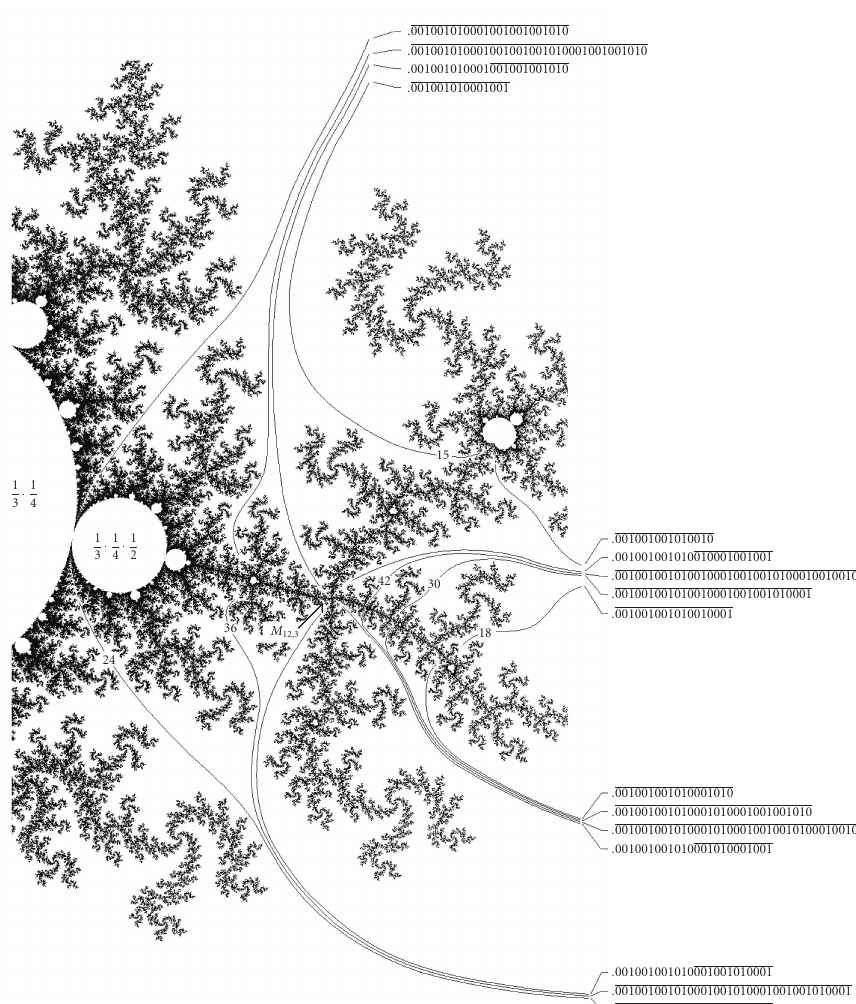
Figure 3.1 . Magnification of a detail of Figure 2.3(c) showing the main node, the Misiurewicz point M 12,3 with four external